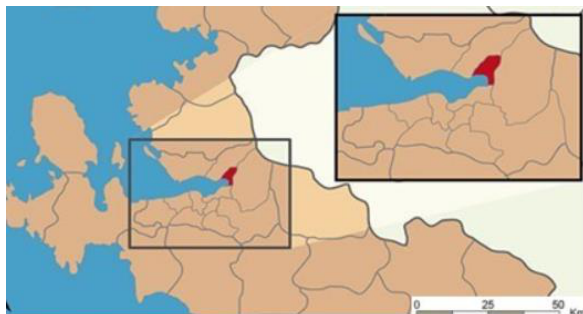
Figure 1. Red area is Bayrakli distinct where the earthquake most effected the area.